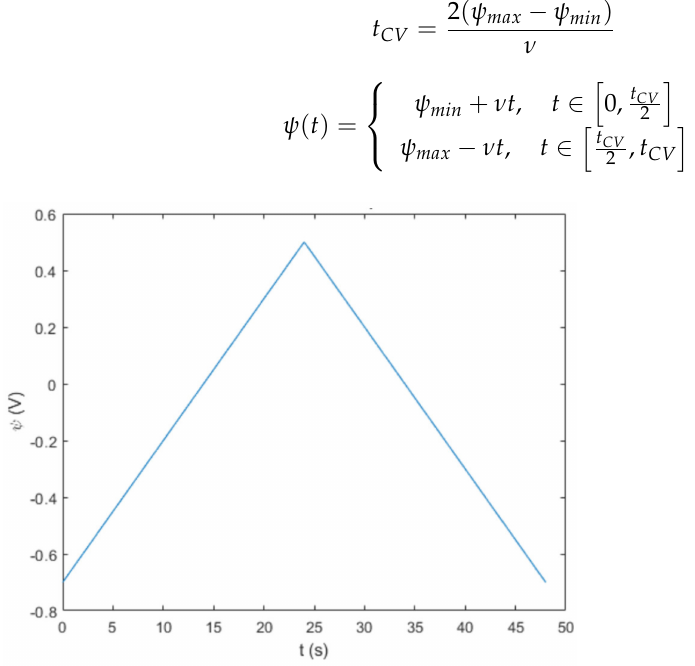
Figure 1. Potential sweep at scan rate of 50